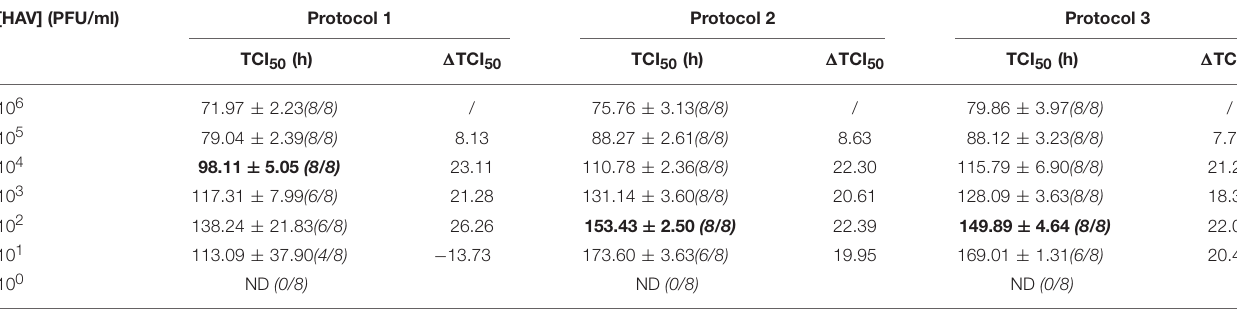
TABLE 4 | Kinetic parameters TCI 50 according to the inoculum level for the three infection protocols. [HAV]